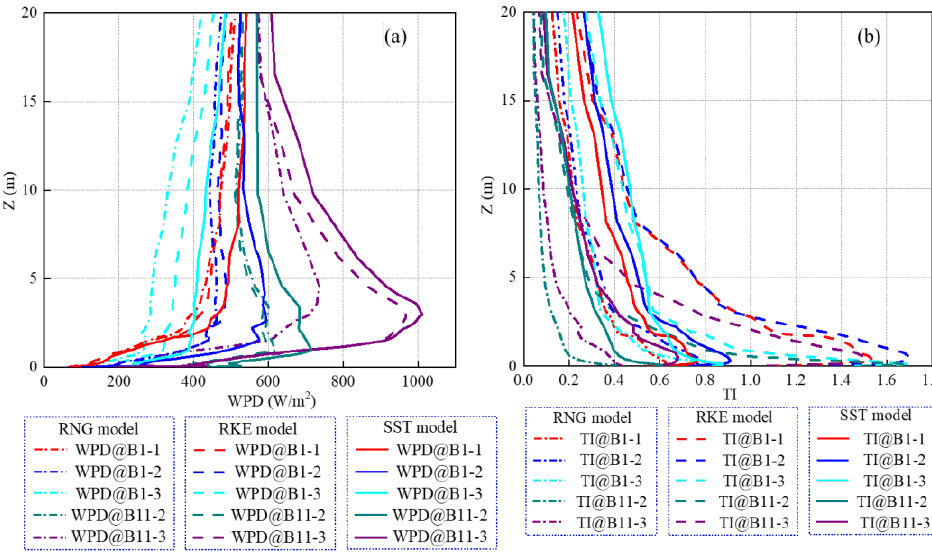
Figure 14. WRAs with three turbulence models: ( a ) WPD profiles; ( b ) TI profiles.